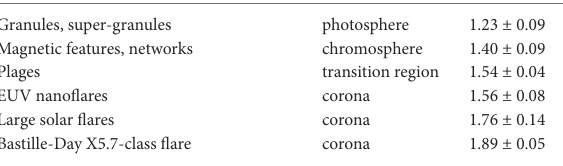
TABLE 4 Summary of solar phenomena, solar location, and range of fractal dimensions. Studies based on the Ca II K line cover both the photospheric and chromospheric